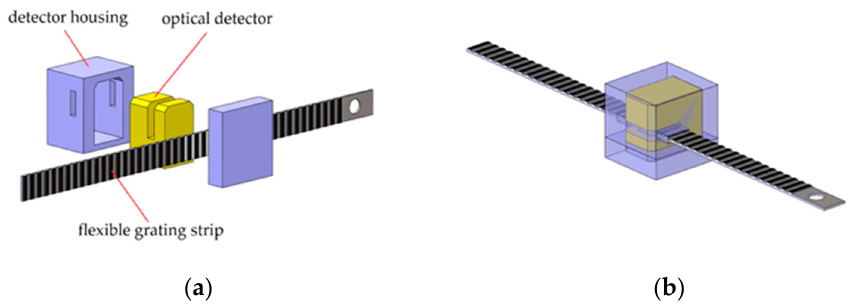
Figure 3. Prototype of the sensing unit. ( a ) Components of the sensing unit; ( b ) Assembly of the sensing unit.